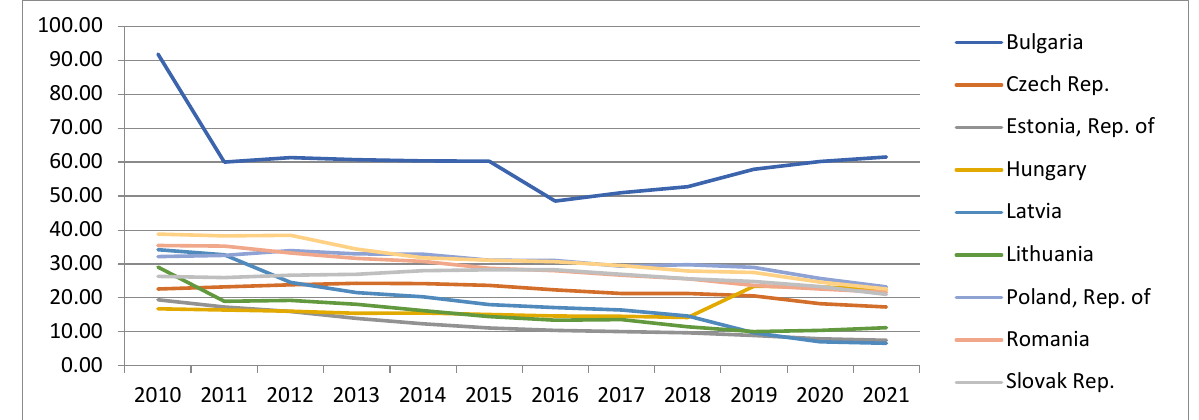
Figure 7. Evolution of commercial bank branches per 100,000 adults.